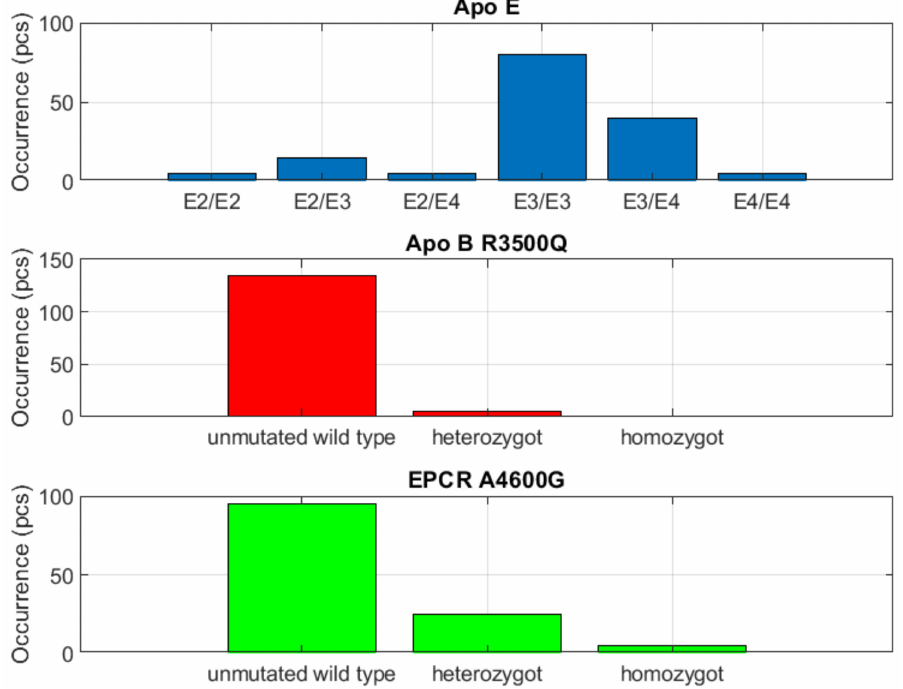
Figure 5. Clearly negative mutation capture. Here is dyslipidemia-atherosclerosis and receptor of endothelial thromboembolism EPCR A4600G